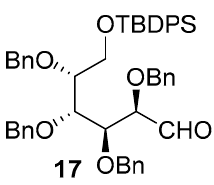
Figure 2. The structure of aldehyde 17 .